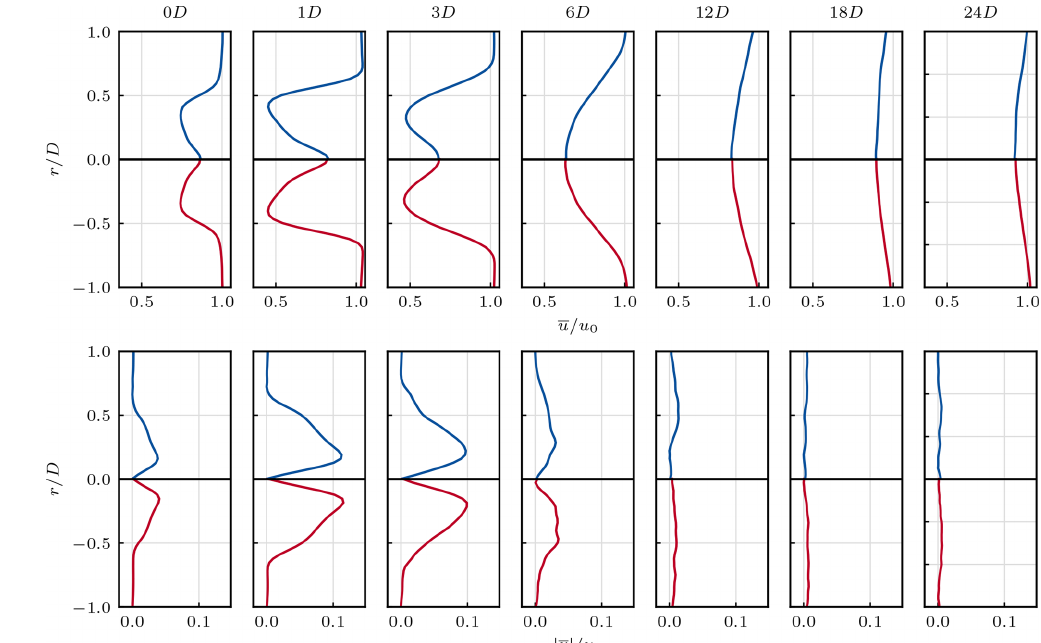
Figure 14. Cross-stream profiles of the mean stream-wise velocity u (top panels) and tangential velocity v (bottom panels) of the CLBM and NS references in turbulent inflow. For the legend, see Fig. 12.